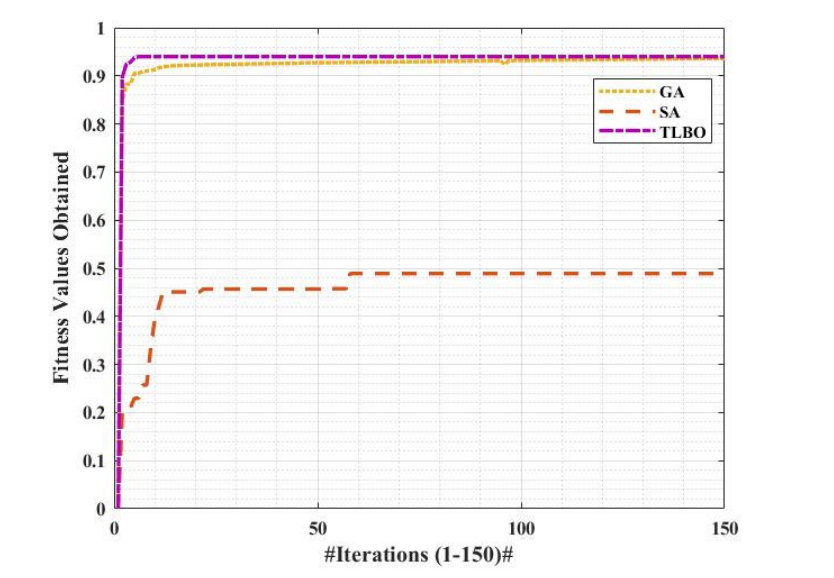
Fig. 12. Comparison of Fitness function of GA, PSO and